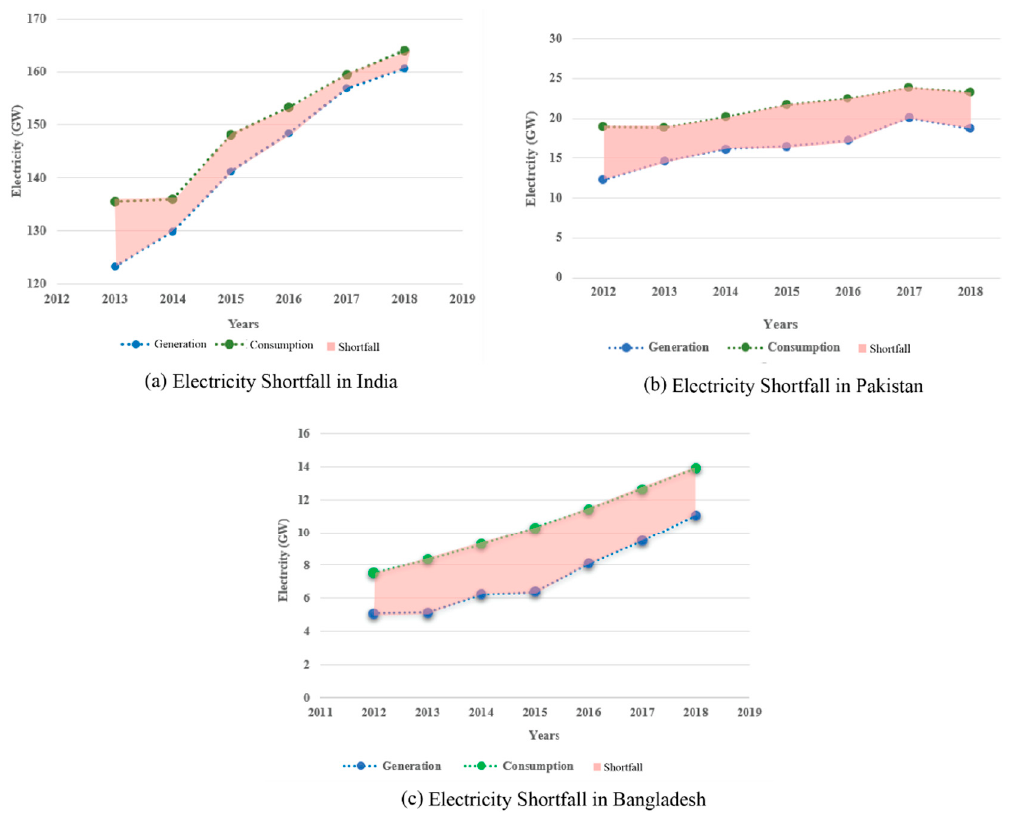
Figure 18. Electricity shortfall in IPB, almost showing a similar trend in electricity generation and shortfall over the years. India being on the high scale of HDI is a closing gap between supply and demand and is expected to overcome the shortfall of electricity in the next few decades.